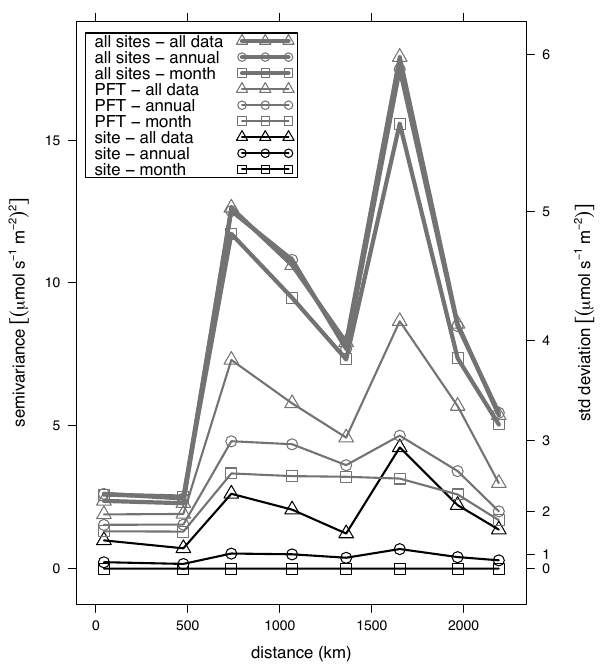
Fig. 4. June-July-August mean VPRM NEE residual empirical semivariograms. Each point represents the mean semivariance and mean separation distance from grouping pairs of towers into 300km bins. VPRM parameterizations are described in Table 2. The left vertical axis shows units of semivariance ( ˆ γ ), and the right verti- cal axis shows units of standard deviation ( σ ). σ is related to ˆ γ by σ = ( 2 ˆ γ) 1 / 2 . The parameter sets with fewer parameters show larger semivariances, reflecting their poorer fit to the data. Visual inspec- tion shows all parameter sets produce strongly increasing semivari- ance at separation distances between 0 and roughly 750km with a relative leveling-off at larger separation